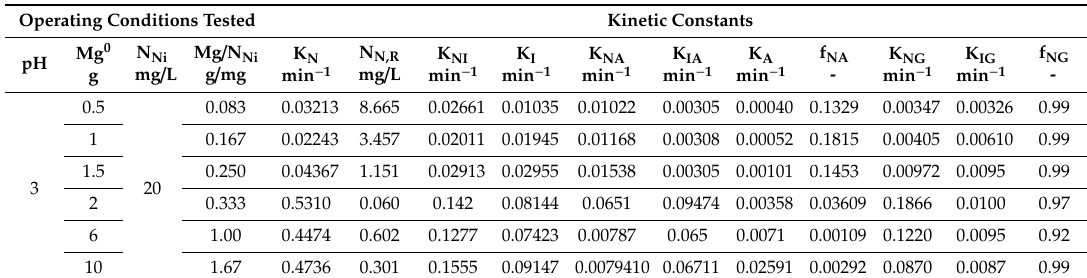
Table 1. Constants obtained from the interpolation of experimental curves of tests at pH 3, with an initial N-NO 3 − concentration of 20 mg / L and varied amounts of Mg 0